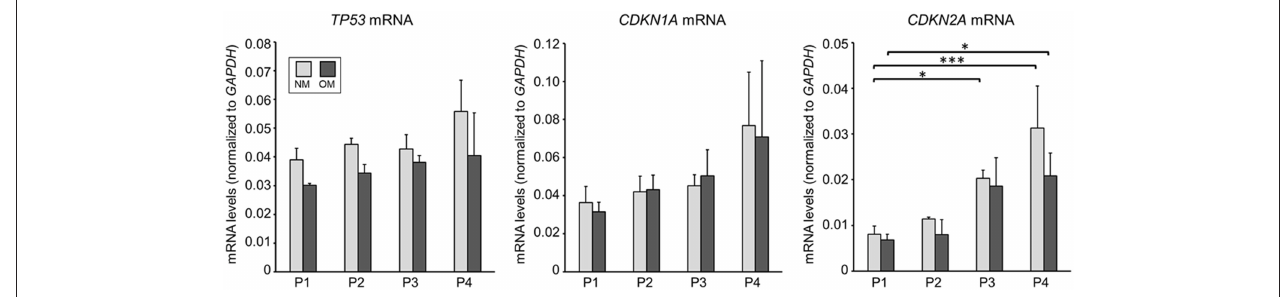
FIGURE 3 | Senescence-associated mRNA levels in human VICs were not altered by OM. mRNA levels of tumor promoting protein p53 ( TP53 ), cyclin dependent kinase inhibitor 1A ( CDKN1A ), and cyclin dependent kinase inhibitor 2A ( CDKN2A ) in calcific aortic valve disease tissue-derived VICs cultured in control normal media